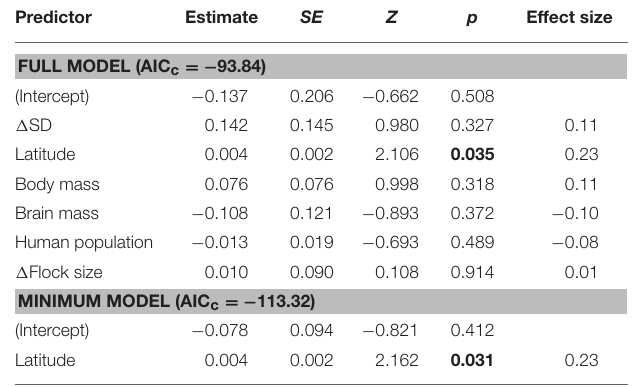
Predictor Estimate SE Z p Effect size